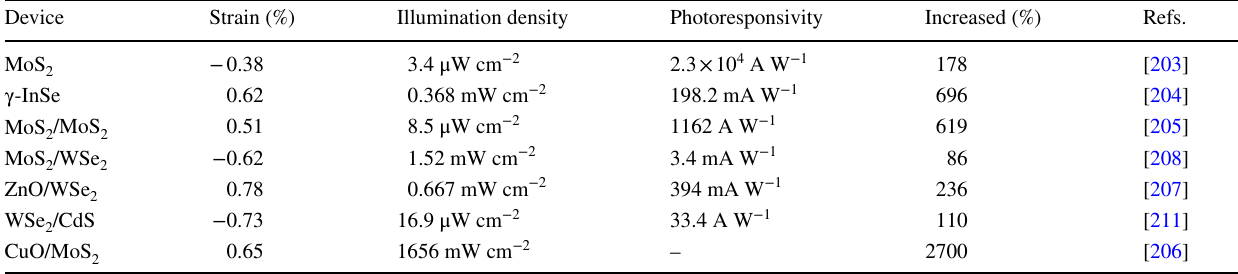
Table 3 A list of piezoelectricity enhancing the performance of the photodetectors constructed by 2D semiconductors and their heterostructures